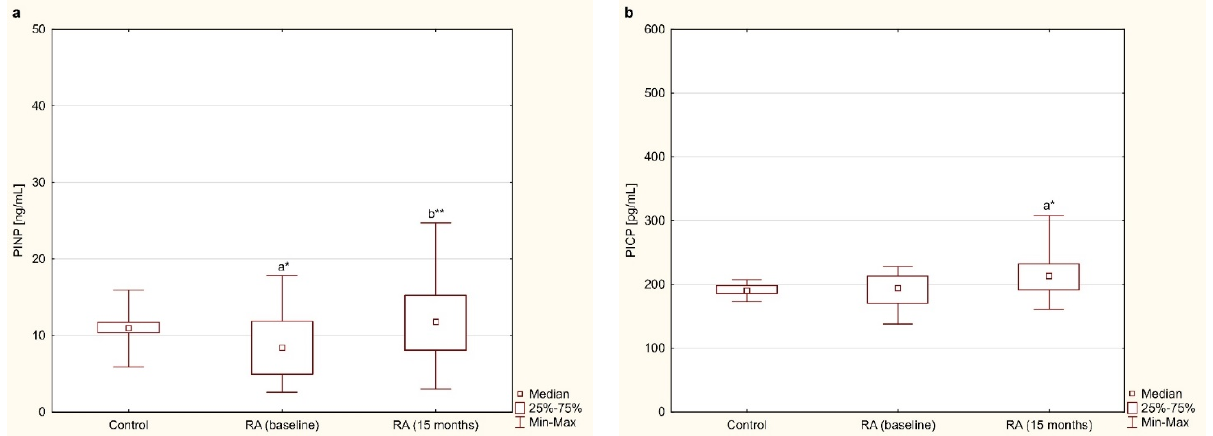
Figure 1. Effect of a 15-month TNF α I therapy on markers of bone formation: PINP ( a ) and PICP ( b ) in women with rheumatoid arthritis, and in healthy women. a * p < 0.01 compared to the control; b ** p < 0.001 compared to the baseline. PICP, C-terminal propeptides of type I procollagen; PINP, N-terminal propeptides of type I procollagen; RA, rheumatoid arthritis; TNF α I, tumor necrosis factor α inhibitors.